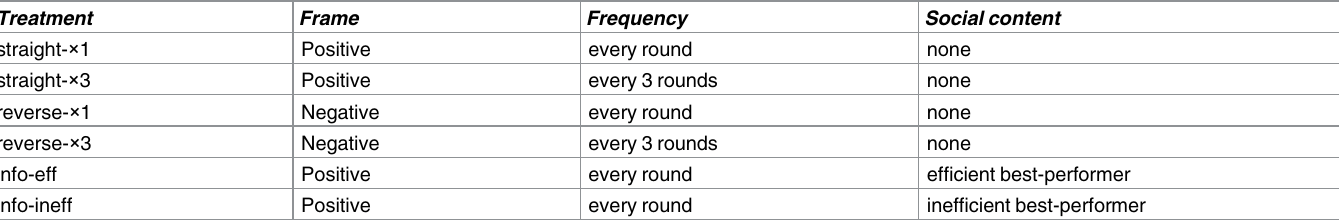
Table 1. Experimental